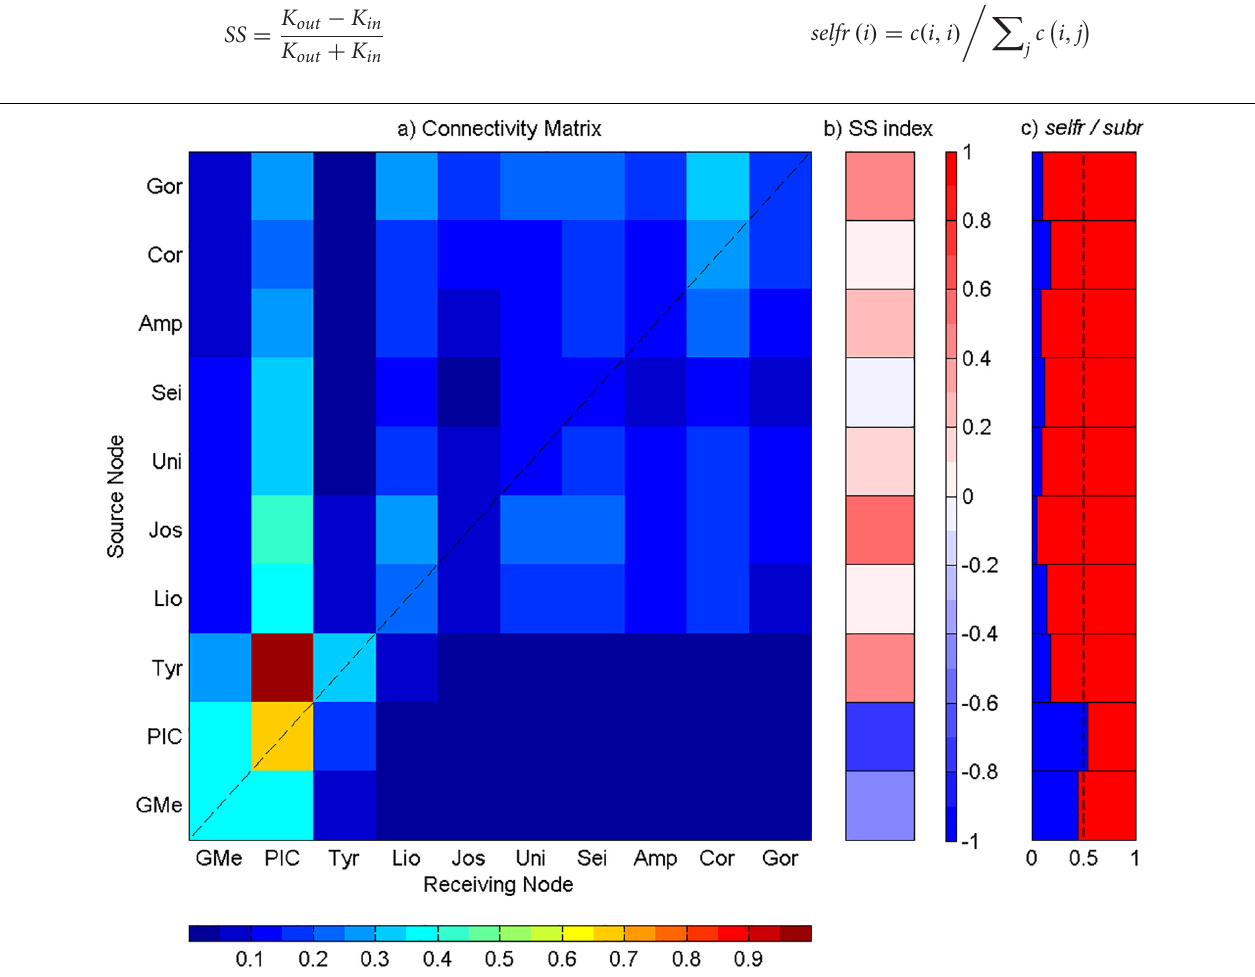
FIGURE 5 | Analysis of the connectivity among Great Meteor and Madeira-Tore complexes at the depth range of 1 to 10 m. (a) Connectivity matrix between the seamounts: GMe – Great Meteor; PIC – Plateau, Irving, and Cruiser; Tyr – Tyro; Lio – Lion; Jos – Josephine; Uni – Unicorn; Sei – Seine; Amp – Ampere; Cor – Coral; and Gor – Gorringe. The y -axis represents seamounts acting as sources and the x -axis represents seamounts acting as sinks. The connectivity degree increases from blue to red. (b) Source–sink indices for each seamount. (c) Self-recruitment ( selfr , blue color) and subsidy-recruitment ( subr , red color) fractions for each seamount. The dashed line corresponds to the reference value of